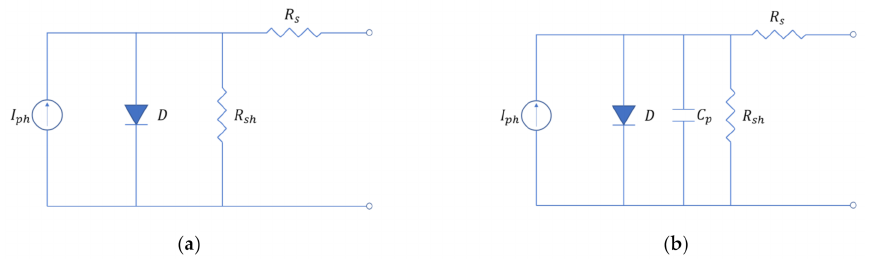
Figure 5. Equivalent circuit of a solar cell: ( a ) DC equivalent circuit; ( b ) AC equivalent circuit. I ph = photogenerated current, R s = series resistance, R sh = shunt resistance, and C p = parallel